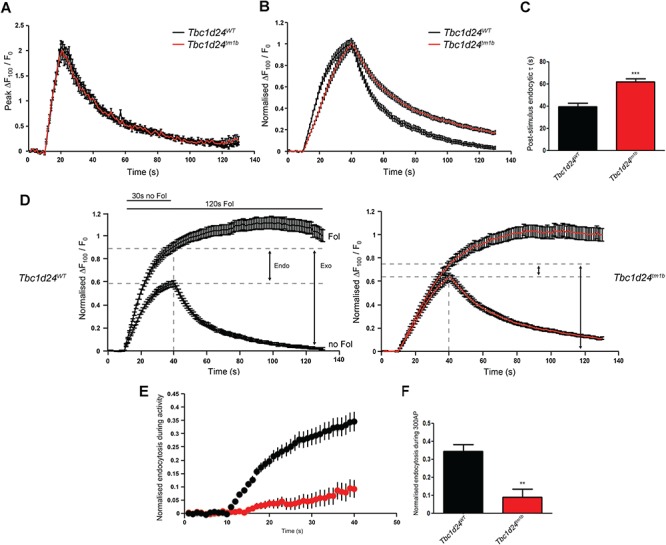
Genetic disruption of Tbc1d24 expression results in defective endocytosis in primary neurons. (A) Average fluorescence traces of hippocampal neurons at 15 DIV expressing the pHluorin SypH 2× in response to 100 stimuli at 10 Hz [N = 188 boutons from 8 coverslips (Tbc1d24WT) or 87 boutons from 5 coverslips (Tbc1d24tm1b)] indicating no difference in the post-stimulus endocytic time constant. (B) Normalized average traces of neurons expressing SypH 2x in response to 300 stimuli at 10 Hz. (C) Comparison of average post-stimulus endocytic time constants following the 300 AP stimulus. The decay phases of ΔF traces were fitted with single exponential functions before normalization and the time constants were calculated from the fits [N = 113 boutons from 5 coverslips (Tbc1d24WT) or 190 boutons from 6 coverslips (Tbc1d24tm1b)]. (D) Time course and extent of endocytosis during neuronal activity were measured using folimycin (Fol). Neurons expressing SypH 2× were stimulated at 10 Hz for 30 s in the absence of Fol. After a 10 min rest, neurons were stimulated at 10 Hz for 120 s in the presence of Fol. Images were acquired during each phase of stimulation. Graph shows average SypH 2× traces from Tbc1d24WT neurons in response to each stimulus. All values were normalized to the maximum fluorescence change at the end of 1200 stimuli in presence of Fol. The short and long vertical arrows indicate the extent of endocytosis and exocytosis at the end of the 300 stimuli (vertical dashed line) at 10 Hz, respectively (N = 162 boutons from 5 coverslips). The same experiment was repeated in Tbc1d24tm1b neurons (N = 200 boutons from 6 coverslips). (E) Time courses of during-stimulus endocytosis for Tbc1d24WT and Tbc1d24tm1b neurons during stimulation (30 s, 10 Hz). Each endocytosis time-course was calculated by subtracting the SypH 2× trace that was acquired in the absence of Fol, from the Fol trace in (D). These traces were fitted with linear functions, the slope of which corresponds to the endocytic rate in arbitrary units per second. (F) Average magnitude of endocytosis calculated during delivery of 300 pulses. Data are expressed as the mean ± SEM. (C,F) **P < 0.01; ***P < 0.001; unpaired t-test.